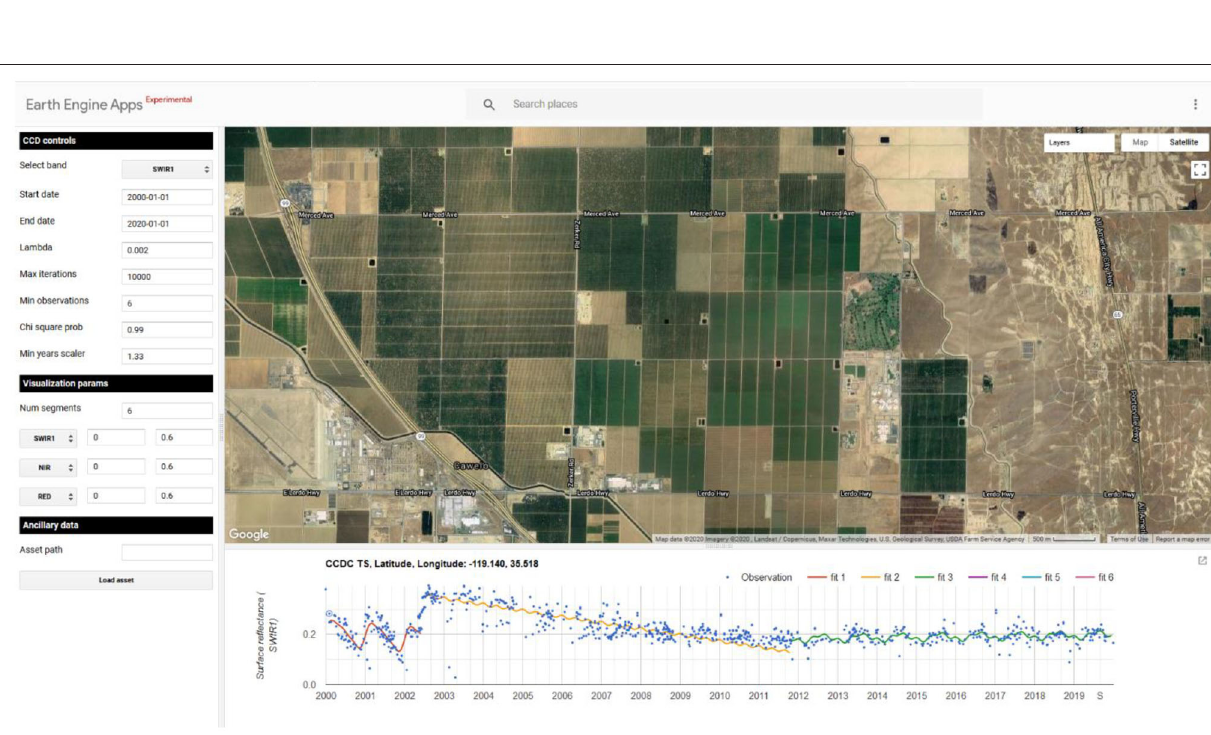
Frontiers in Climate | www.frontiersin.org